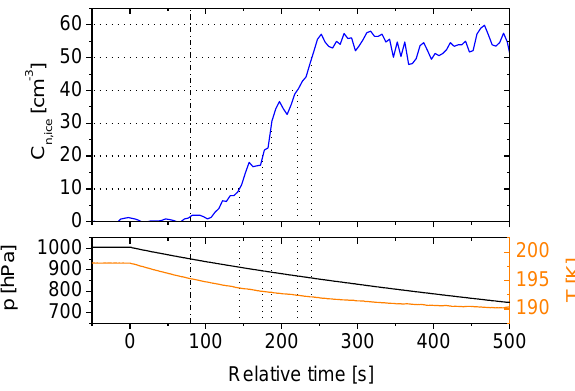
Fig. 3. Division of ice particle growth into individual bins in SIGMA. The blue line shows a typical evolution of the ice num- ber concentration C n, ice during an AIDA expansion experiment as measured by the WELAS optical particle counter. Ice onset is indi- cated by the dashed dotted line and is chosen as start time t 1 for ice growth in the first ice growth bin. Equidistant division of C n, ice with respect to the maximally reached ice number concentration yields the ice growth start times t i in the subsequent ice growth bins (dot- ted